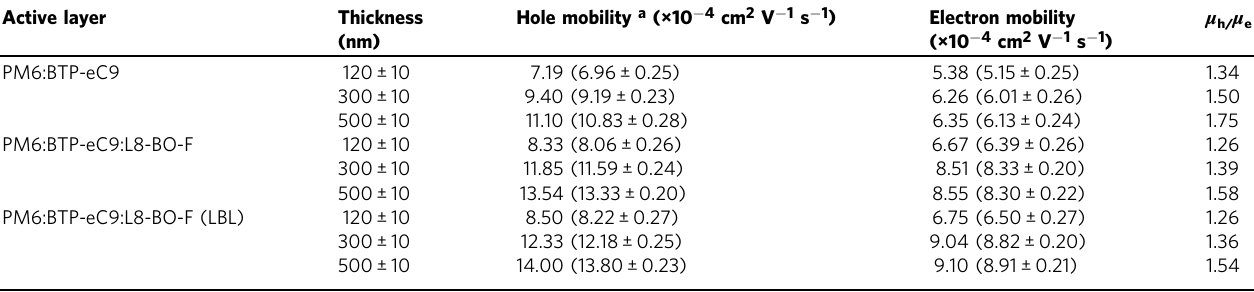
Table 2 Hole mobility and electron mobility of PM6:BTP-eC9 and PM6:BTP-eC9:L8-BO-F devices with different thicknesses. Active layer